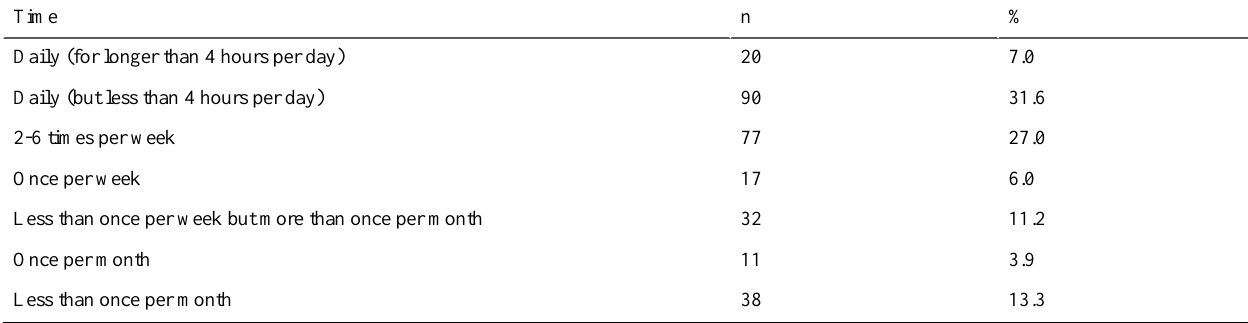
Table 2. Time spent looking at or using DSH websites/forums in an average week (N=329). %nTime